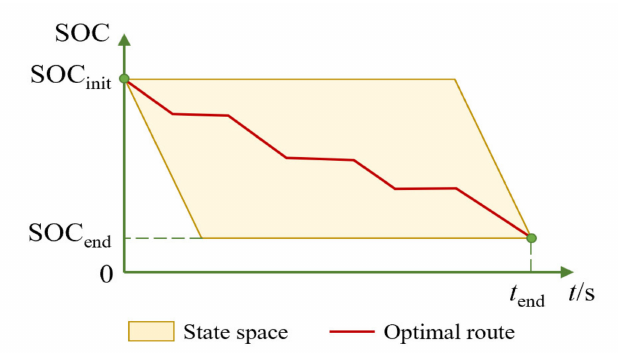
Figure 14. Schematic diagram of the principle of dynamic programming